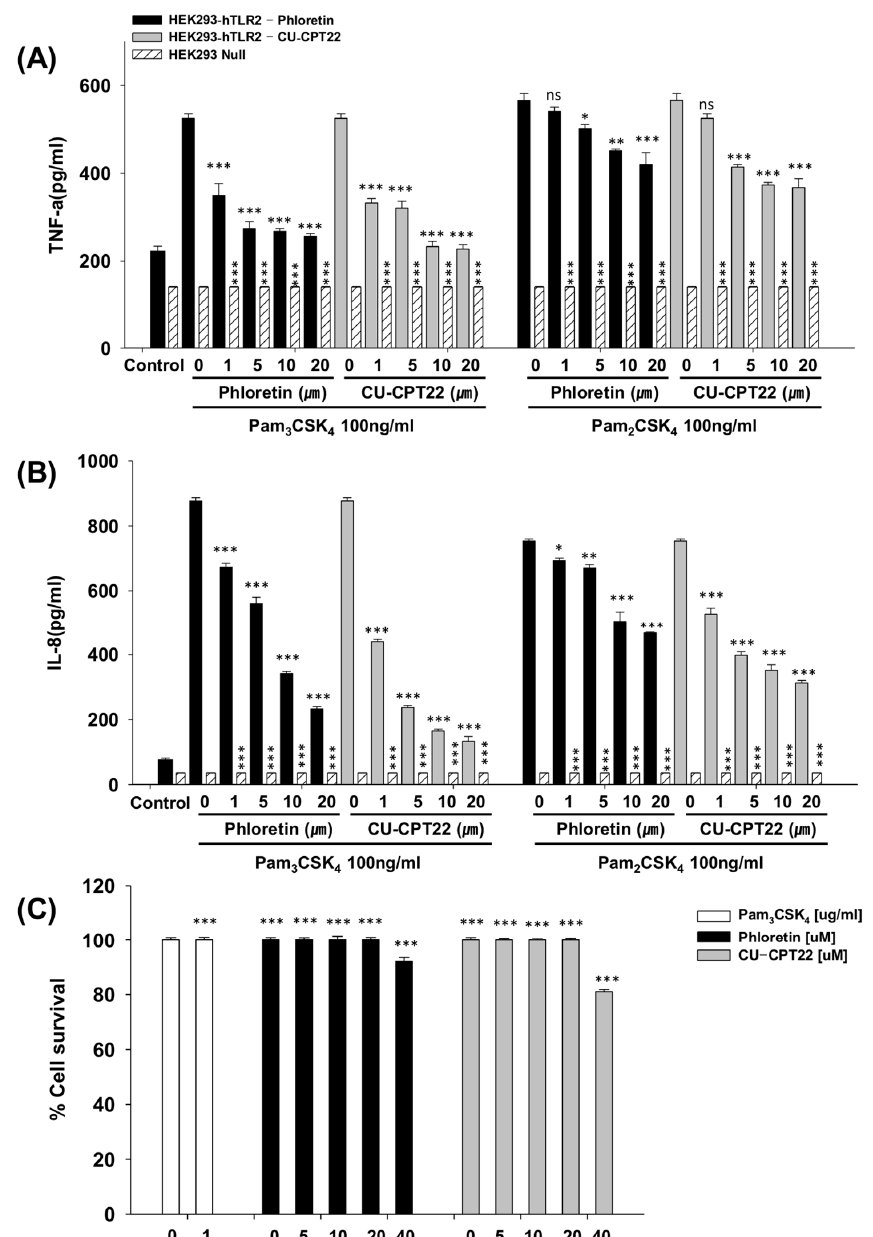
Figure 3. Effect of phloretin on cytokine levels, TNF- α ( A ) and IL-8 ( B ), in 100 ng/mL Pam 3 CSK 4 - and Pam 2 CSK 4 -stimulated HEK293-hTLR2 cells and HEK293-null cells. HEK293 cells were pretreated for 1 h with phloretin (1, 5, 10, 20 µM) or CU-CPT22 (1, 5, 10, 20 µM) before stimulation with the agonists, Pam 3 CSK 4 or Pam 2 CSK 4 (100 ng/mL), for 16 h. Supernatants were collected and the levels of TNF- α and IL-8 in Pam 3 CSK 4 - or Pam 2 CSK 4 -stimulated HEK293-hTLR2 cells were determined by ELISA. * p < 0.05, ** p < 0.01, and *** p < 0.001 compared to HEK293-hTLR2 cells treated with agonists only. ( C ) Concentration-dependent toxicity of phloretin, CU-CPT22, and Pam 3 CSK 4 against HEK293-hTLR2 cells. *** p < 0.001 compared to HEK293-hTLR2 cells treated with agonists only. The error bars represent ± SEM. n.s. represents no significance.